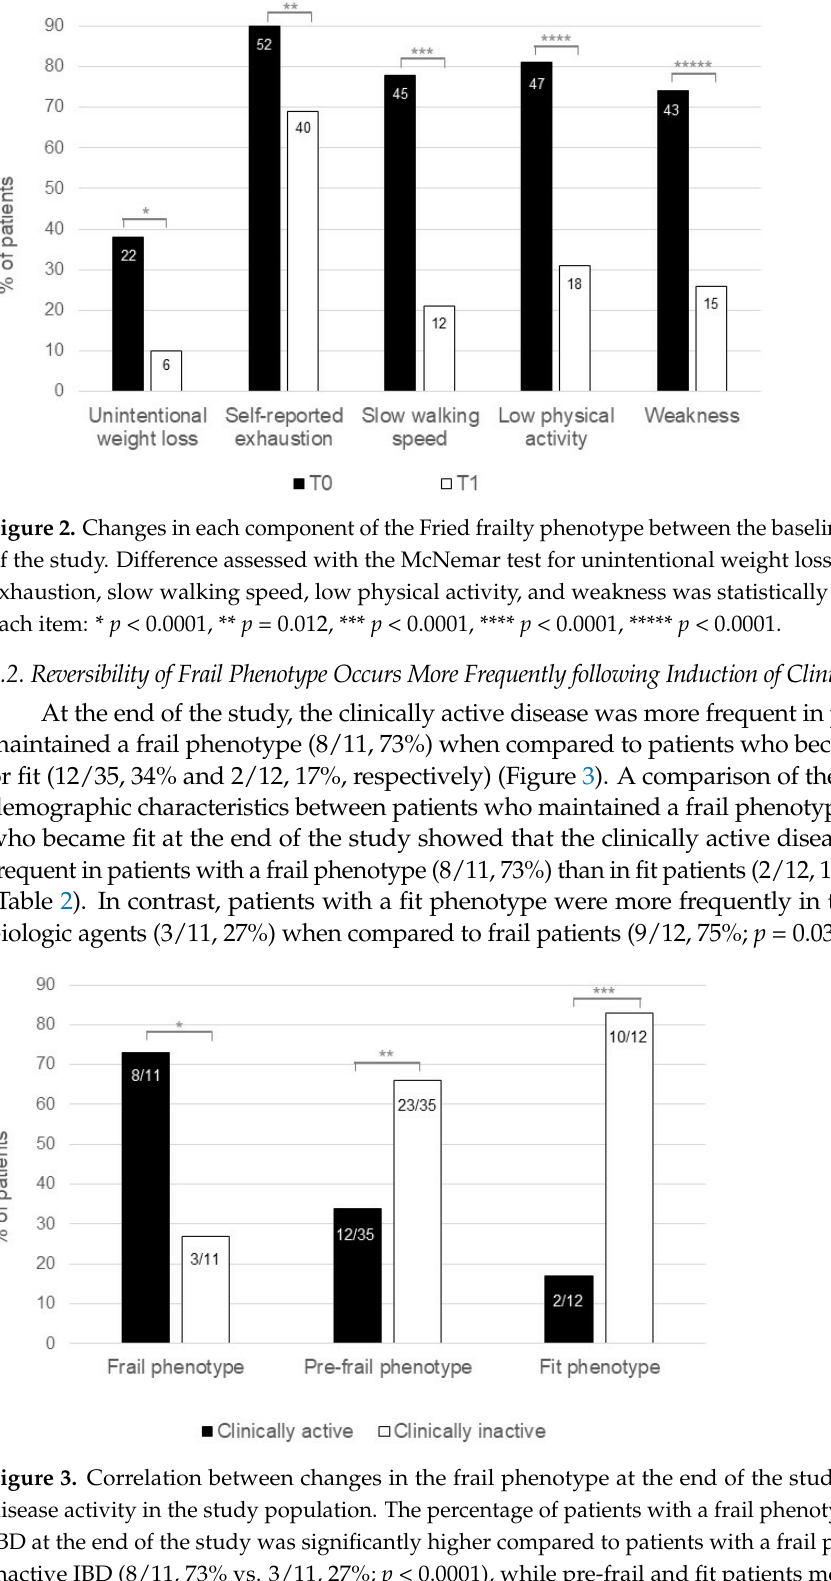
Figure 3. Correlation between changes in the frail phenotype at the end of the study and clinical disease activity in the study population. The percentage of patients with a frail phenotype and active IBD at the end of the study was significantly higher compared to patients with a frail phenotype and inactive IBD (8/11, 73% vs. 3/11, 27%; p < 0.0001), while pre-frail and fit patients more frequently had an inactive disease ( p < 0.0001 in both cases). * p < 0.0001, ** p < 0.0001, *** p < 0.0001. Table 2. Demographic and clinical characteristics of patients with frail phenotype compared to patients with fi t phenotype at the end of the study (T1). CD: Crohn’s disease; UC: ulcerative colitis; BMI: body mass index; EIMs: extraintestinal manifestations; ISS: immunosuppressors.